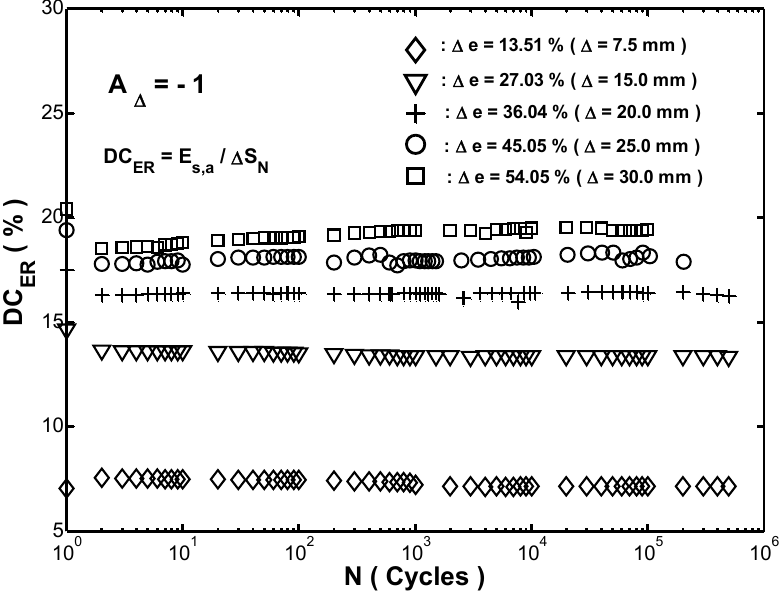
Figure 6. Relationship between cyclic effectiveness index ( DC ER ) and number of cycles ( N ) in cyclic compression testing with five different strain ranges.